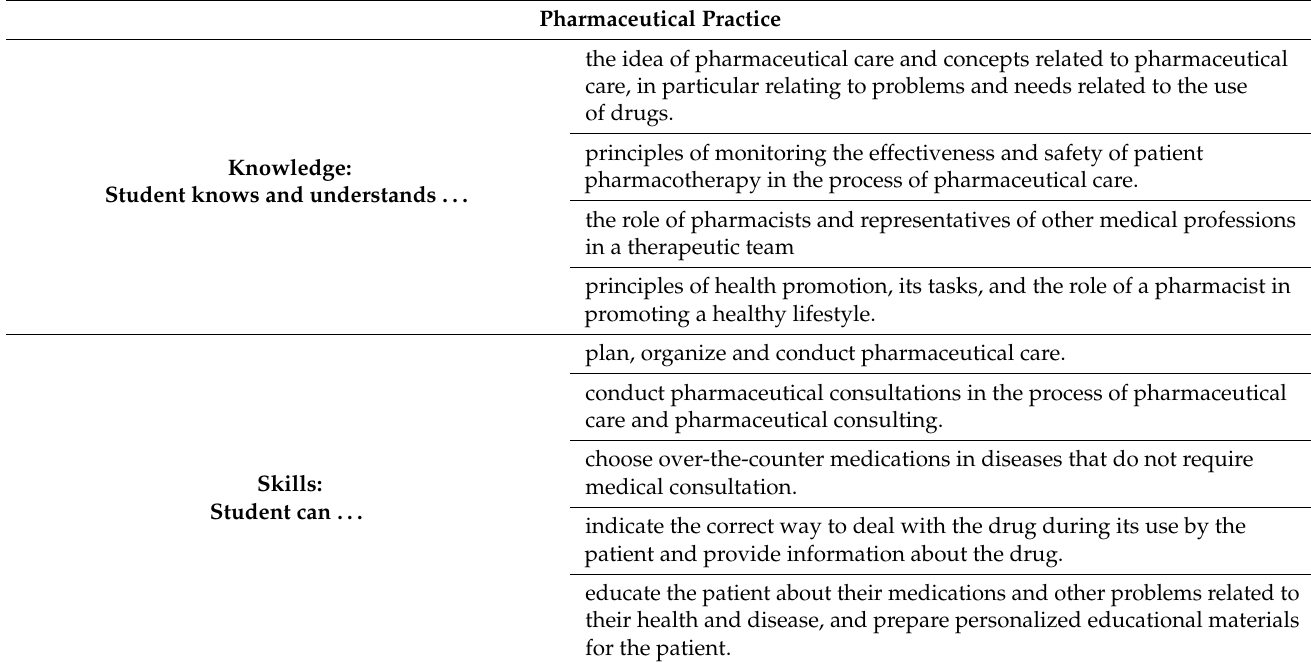
Table 1. Examples of learning outcomes related to the implementation of pharmaceutical care services, as defined in the Regulation of the Minister of Science and Higher Education of 26 July